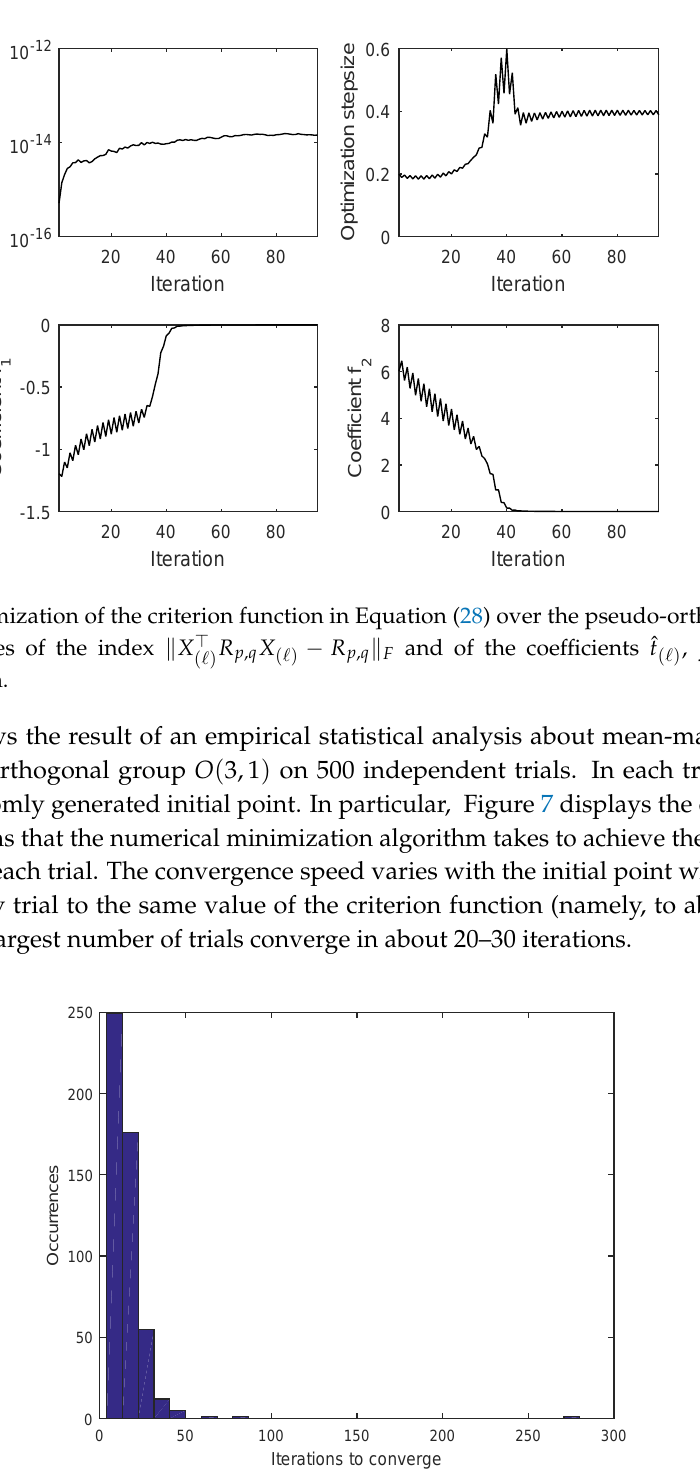
Figure 7. Minimization of the criterion function in Equation (28) over the pseudo-orthogonal group O ( 3,1 ) : Distribution of the number of iterations to converge on each trial on a total of 500 independent